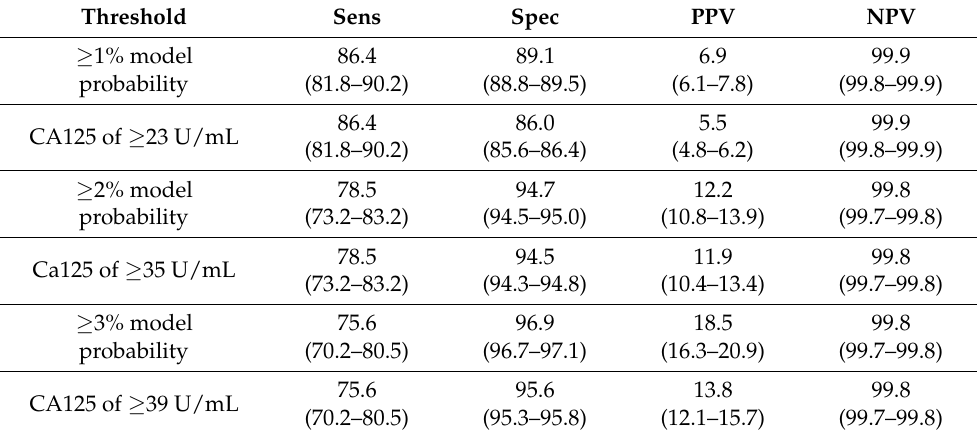
Table 4. Diagnostic accuracy metrics for a range of Model 1 thresholds and for CA125 at equivalent